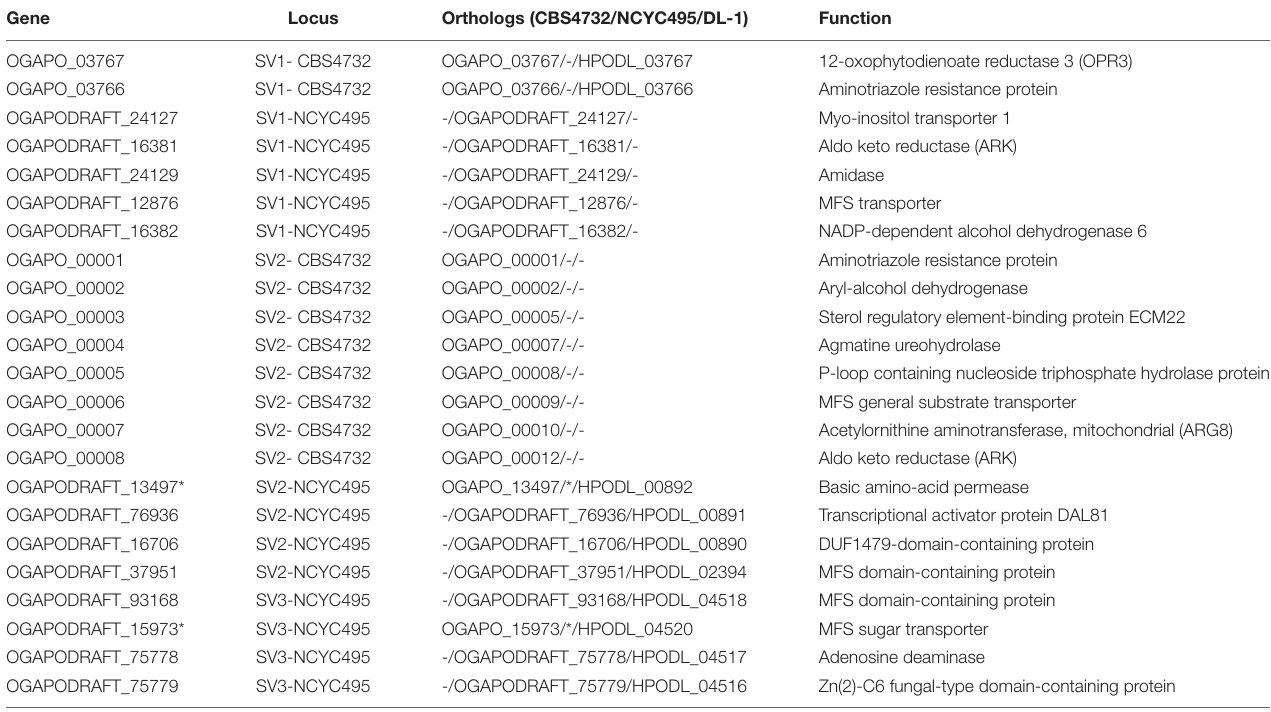
TABLE 2 | Twenty five different genes between HU-11/CBS4732 and